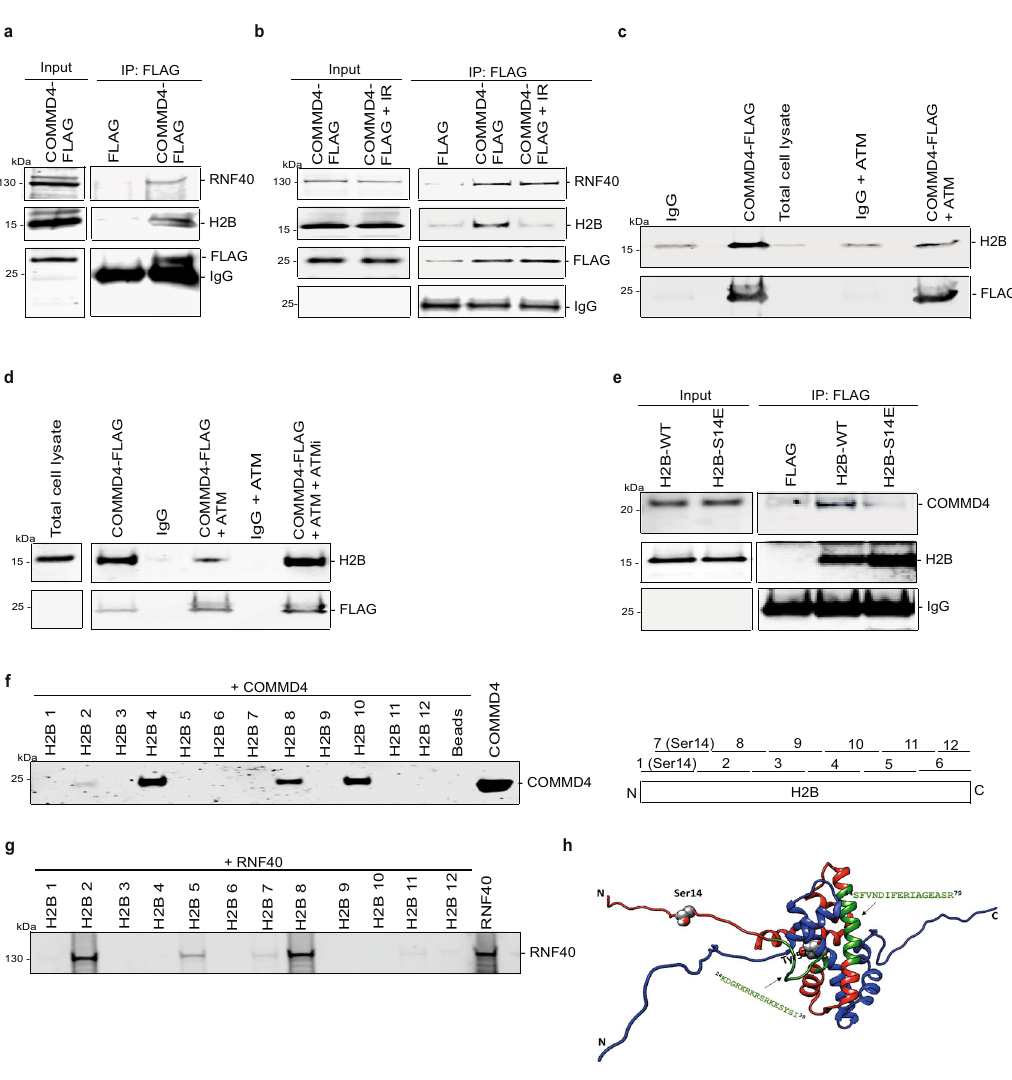
Fig. 3 COMMD4 interacts with H2B and RNF40. a Empty vector (FLAG) and COMMD4-FLAG were immunoprecipitated from HeLa cells and the co- eluting proteins were immunoblotted with antibodies shown. b Immunoprecipitation as a , but this time cells were treated with 6 Gy IR. c A direct interaction for COMMD4 and H2B ± recombinant ATM. d A direct interaction between COMMD4 and H2B ± recombinant ATM and the ATM inhibitor (ATMi) KU-55933. e FLAG and FLAG-tagged H2B WT, and S14E mutant were immunoprecipitated from HeLa cells and the co-eluting proteins were immunoblotted with antibodies against COMMD4 and H2B. IgG heavy chain shows the loading. f Direct interaction between COMMD4 and H2B demonstrating the speci fi c binding region within H2B. No binding was seen in the negative control with only the beads and recombinant COMMD4 (beads), while expression of His-tagged COMMD4 (COMMD4, right most lane) is seen. Schematic on the right shows peptide regions within H2B and Supplementary Table 1 shows the peptide sequences. g Direct interaction between RNF40 and H2B demonstrating the speci fi c binding regions within H2B. Expression of recombinant RNF40 is seen in the control lane. h A three dimensional structure (PDB code 2RVQ) of the heterodimer H2A-H2B wherein H2A and H2B are shown in blue and red ribbon representation, respectively. Tails of histones are disordered and in extended conformation. The phosphorylation sites are shown as